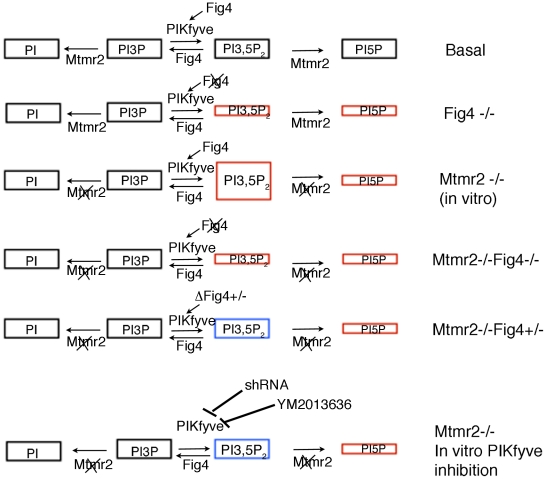
Model of MTMR2 and FIG4 phosphatase activities in the control of PtdIns3P- PtdIns(3,5)P
2 metabolism.In red, altered levels of PIs due to loss of MTMR2 and/or FIG4 are depicted. In blue, rebalanced levels of PtdIns(3,5)P
2 in Mtmr2-null cells upon Fig4 heterozygosity and downregulation of either PIKfyve expression or inhibition of its activity are shown.